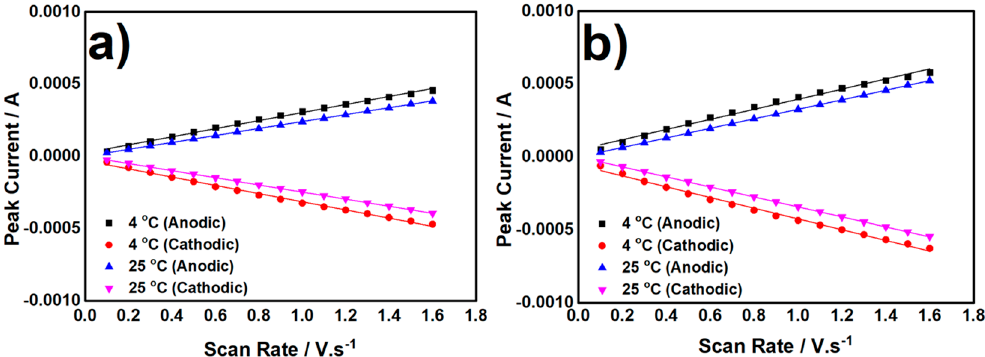
Figure 5. Linear line between peak current vs. scan rate at various scan rate from 100 to 1600 mV · s − 1 of ( a ) CNT/GOx and ( b ) CNT/PEI/GOx which stored at 4 °C and 25 °C for 120 days. All experiment conducted under anaerobic condition by feeding N 2 gas with flow rate 100 mL · min − 1 and 0.1 M PBS pH 7.4 acted as the electrolyte.